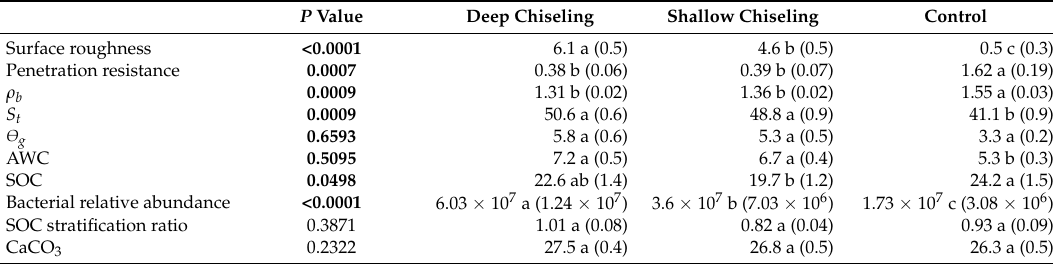
Table 1. Treatment effect on the soil surface roughness (%), penetration resistance (MPa), bulk density